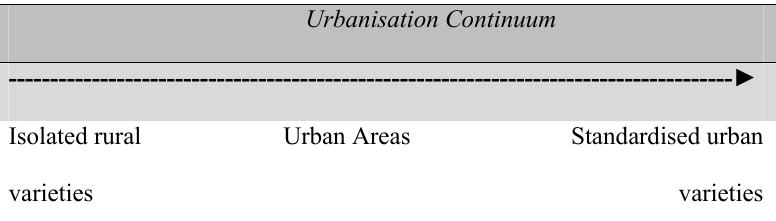
Figure 4. Urbanisation Continuum regarding the BP variation analysis, according to Bortoni-Ricardo (2004) Urbanisation Continuum ---------------------------------------------------------------------------------------